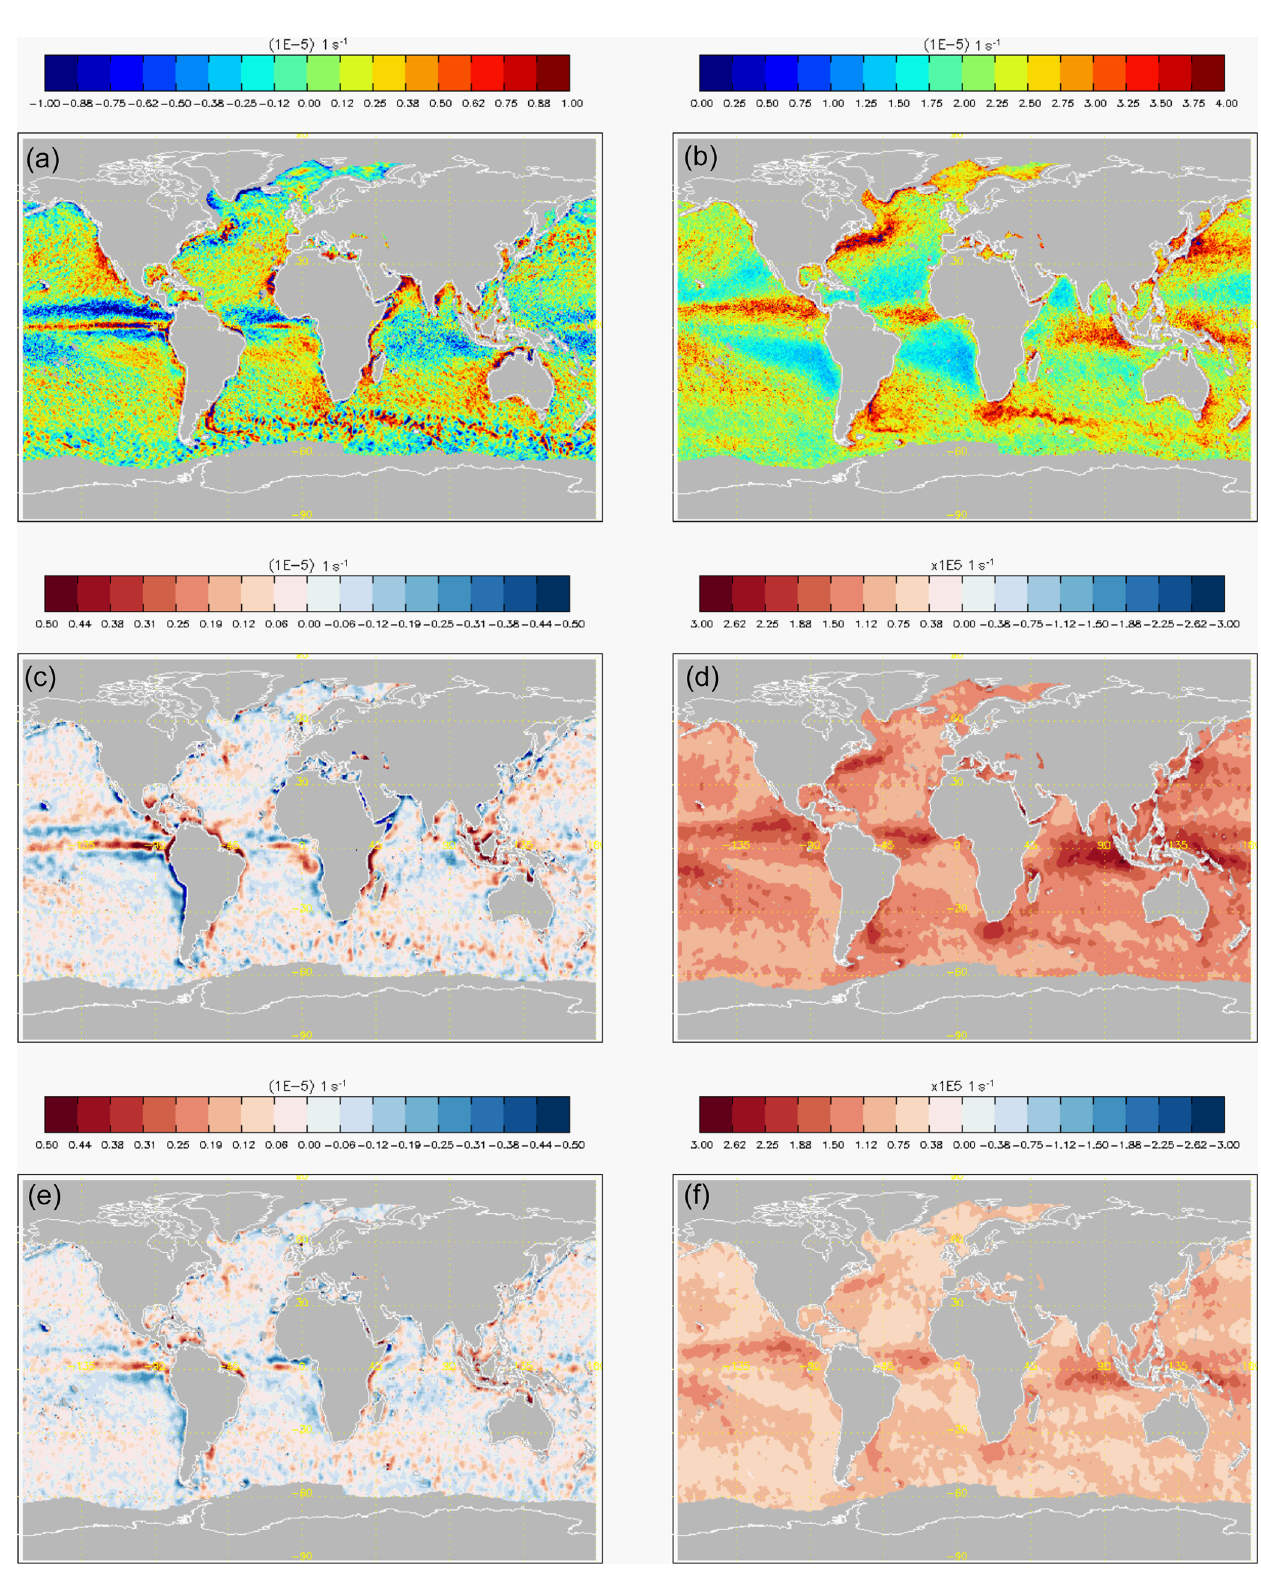
Figure 8. Global maps of annual mean (a) and eddy (b) wind divergence from ASCAT and differences with ERA-Interim (c, d) and ERA5 (e, f) first-guess winds over 2016. Note the color scale